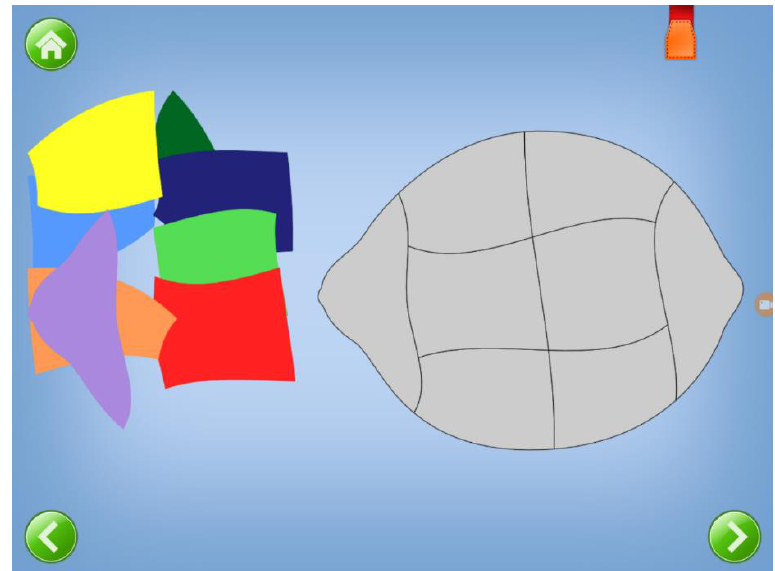
Figure 2. Screenshot of Puzzle Game.